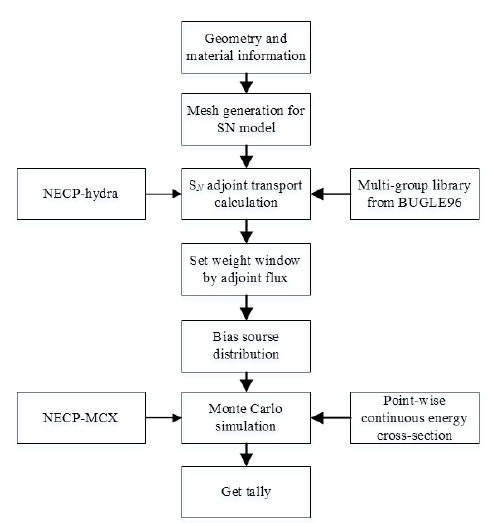
Figure 1. Flow char of the hybrid Monte-Carlo-deterministic